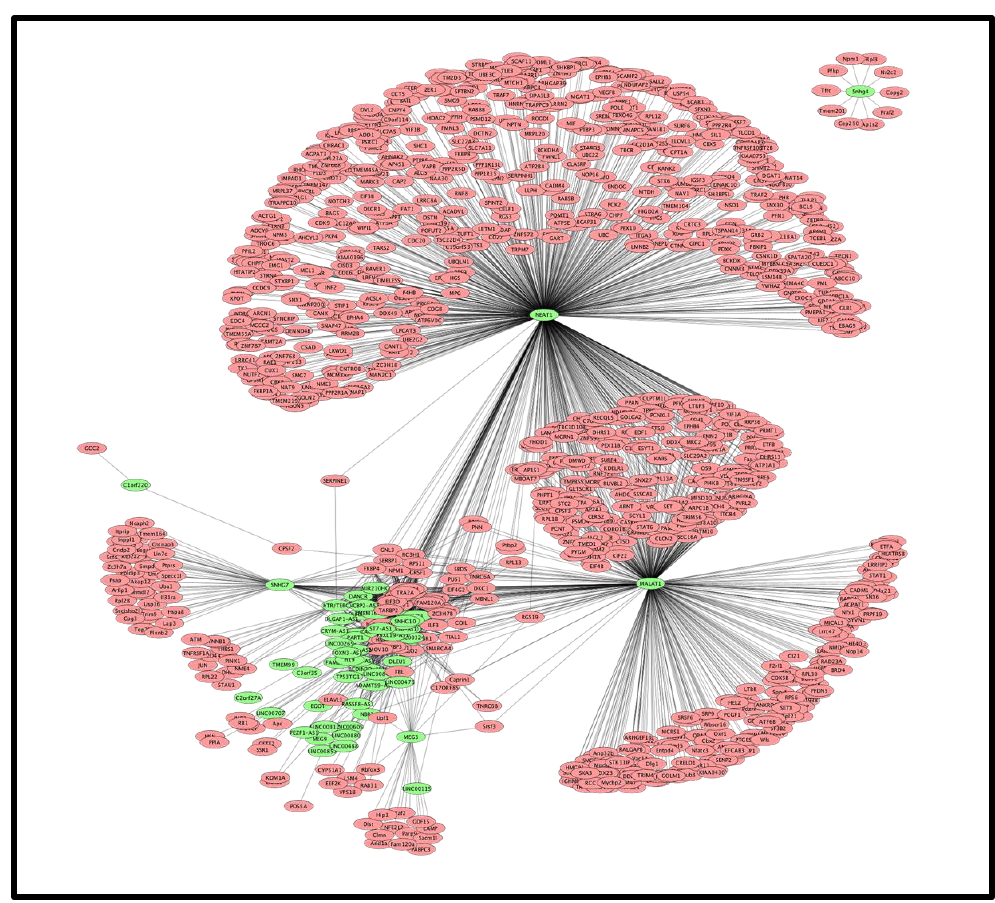
Figure 2. Cytoscape representation of the lncRNA-target interactions. Nodes in green color filled circles represent the lncRNA while the nodes in magenta color filled circles represent the target proteins/genes. Edges (lines joining the nodes) represent the interaction of lncRNA with genes/proteins obtained from NPInter v4.0.